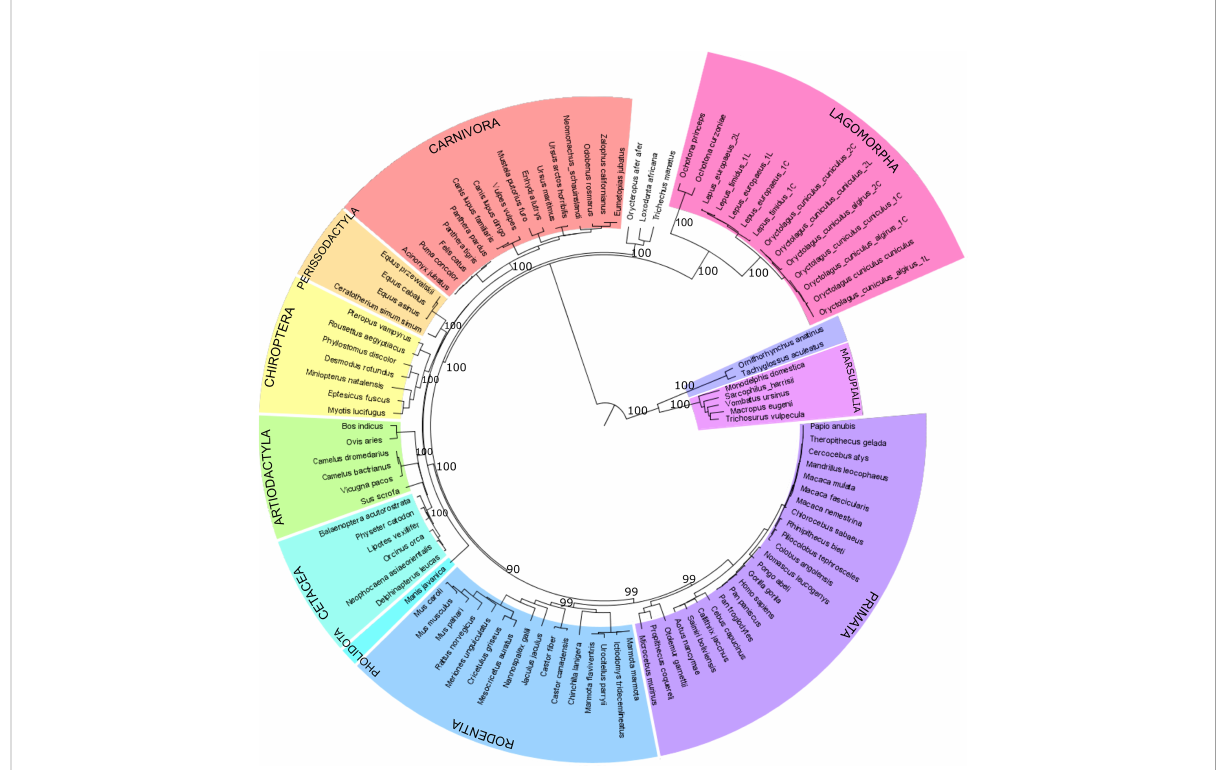
FIGURE 1 Phylogenetic tree of mammalian pIgR gene. Maximum likelihood (ML) method and the GTR+G+I model of nucleotide substitution were used to obtain the pIgR phylogenetic tree. Mammalian orders are highlighted in different colors. Bootstrap values are indicated near most relevant branches. For Lagomorpha sequences the last letter in the name identi fi es the long and short isoform that we sequenced, L identi fi es the long isoform and C the short